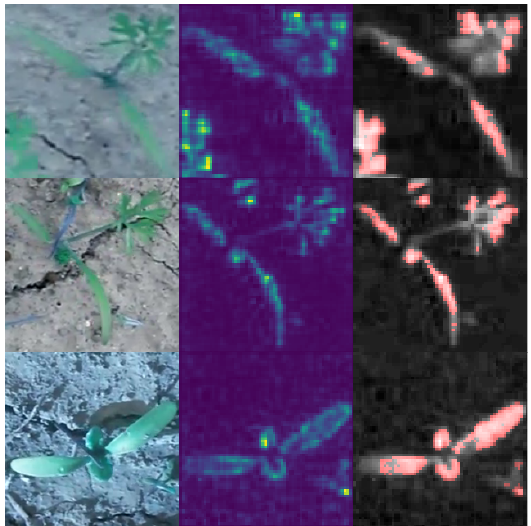
Figure 9. Example images showing correctly classified plant images, where parts of other plants were used for classification. The left images show the raw RGB images. The center images show the LRP result. The right images show excess green images (gray-scaled images) overlayed by the LRP results thresholded using the statistical test for saliency maps (red